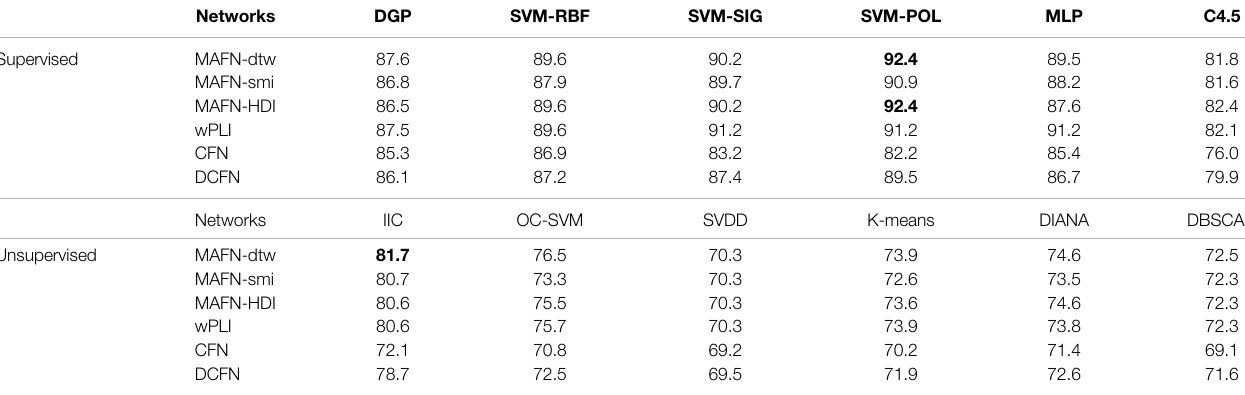
The best-performing methods were highlighted (bold).